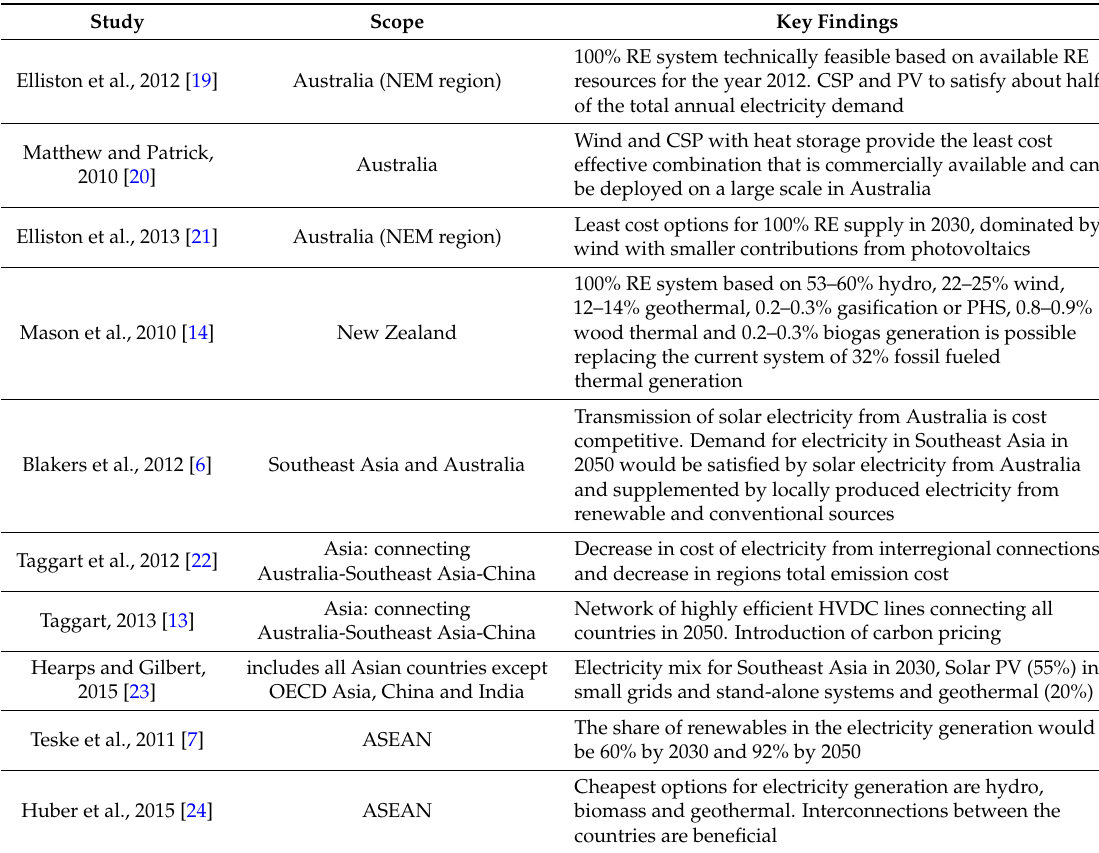
Table 1. Various studies undertaken on 100% renewable energy (RE) for Southeast Asian region. NEM: national electricity market; CSP: concentrating solar thermal power; PV: photovoltaic; HVDC: high voltage direct current; OECD: Organisation for Economic Co-operation and Development; and ASEAN: Association of Southeast Asian Nations.